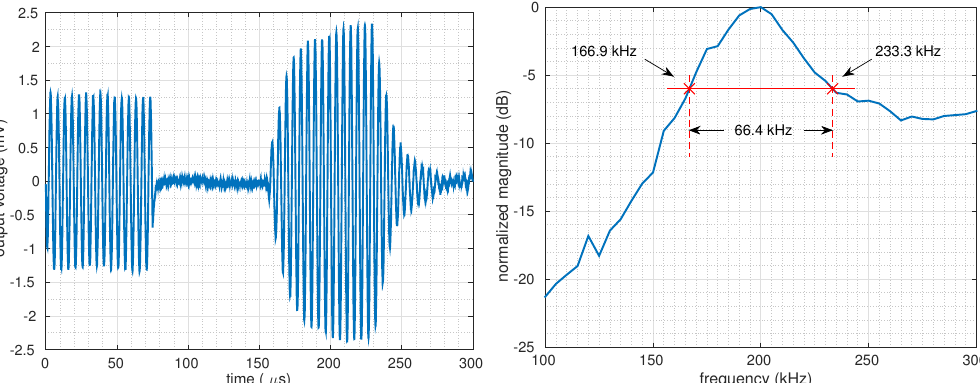
Figure 6. Output signal of RX-CMUT for a tone burst of 15 cycles at 200 kHz ( left ), normalized magnitude for a frequency sweep from 100 to 300 kHz ( right